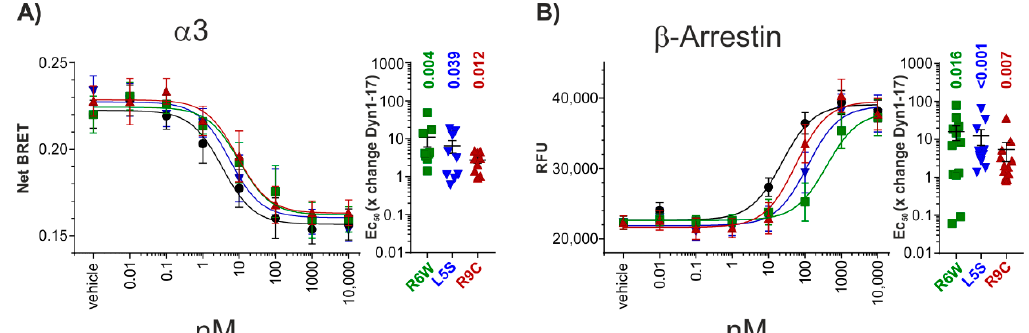
Figure 3. Signal bias investigation for DynA_1-17 (Black), DynA_R6W (green), DynA_L5S (blue), and DynA_R9C (red) peptides at hKOR. ( A ) Left: Dose response curve obtained from TRUPATH (BRET assay) measuring G-protein dissociation in HEK293 cells transiently transfected with hKOR and the G α 3 subunit. Right: Magnitude change in EC 50 induced by DynA_1-17 SCA23 mutant peptides for G α 3 subunit in comparison to mean same day DynA_WT control. ( B ) Left: Dose response curve obtain from PRESTO-Tango assay measuring β -arrestin recruitment in HEK293 cells transiently transfected with hKOR. Right: Magnitude change in EC 50 induced by DynA_1-17 and the SCA23 mutant peptides in comparison to mean same day control. Data are shown as mean ± SEM. Wilcoxon Signed Rank Test; p -values are indicated in the figure.